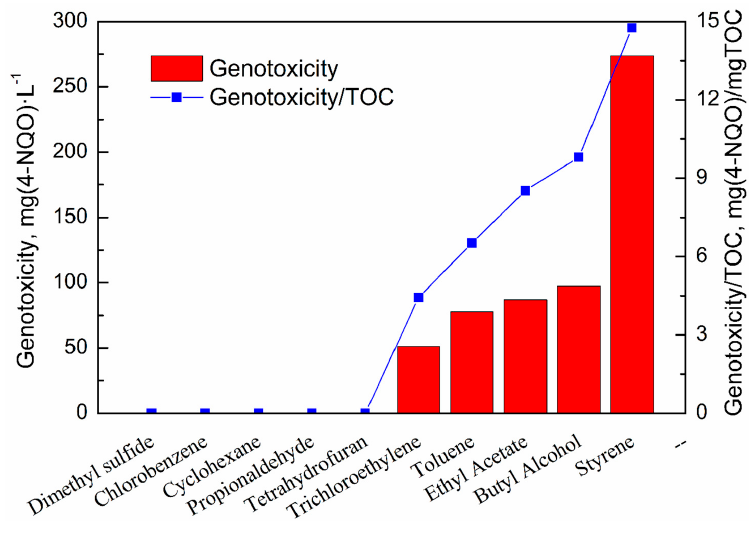
Figure 4. Genotoxicity and genotoxicity/TOC of the off-gas absorption solutions for 10 VOCs.